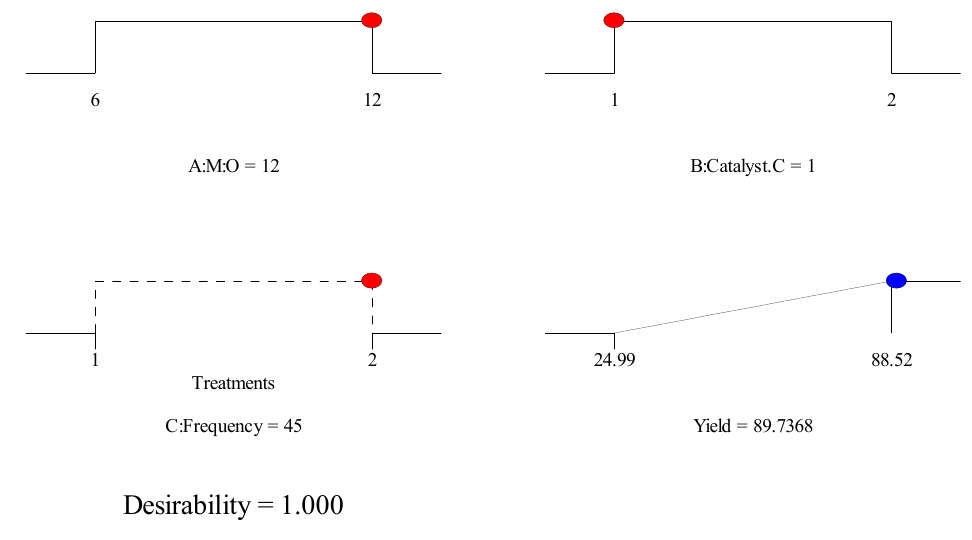
Figure 7. Desirability ramp of yield.